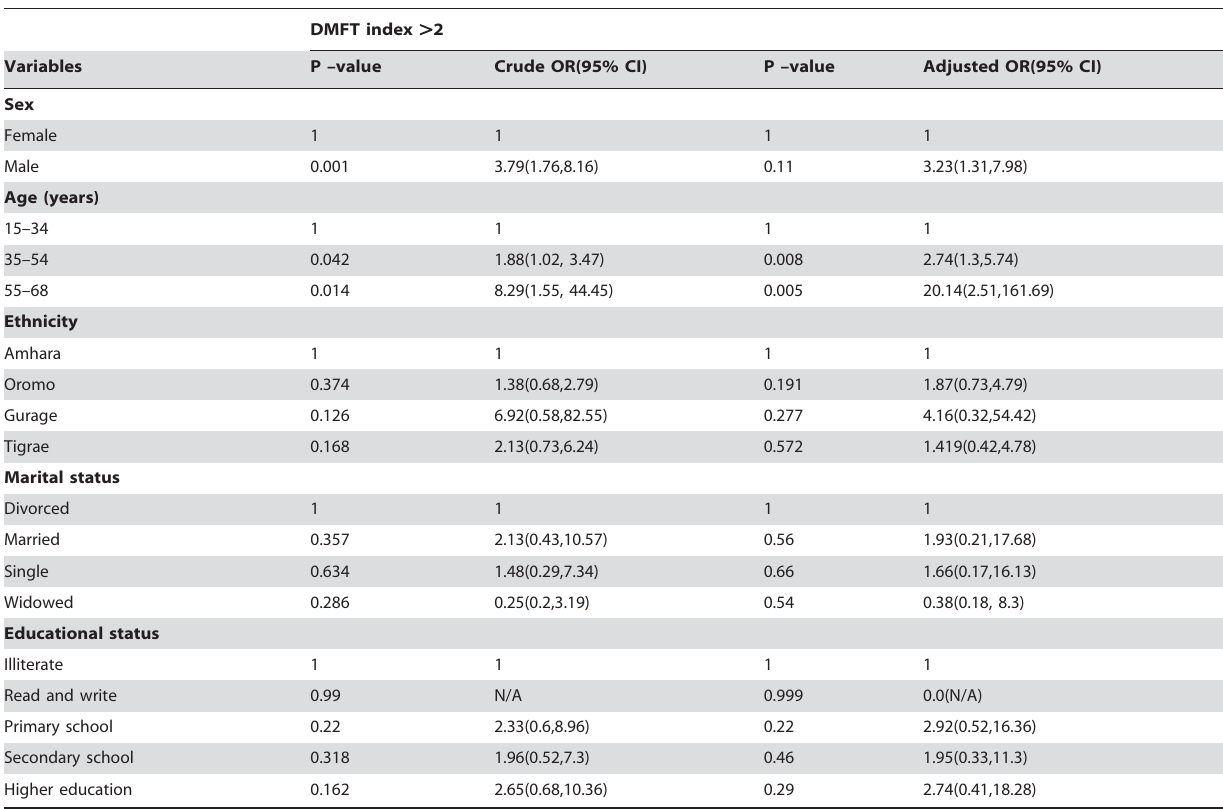
Table 2. Association of mean DMFT index and socio-demographic